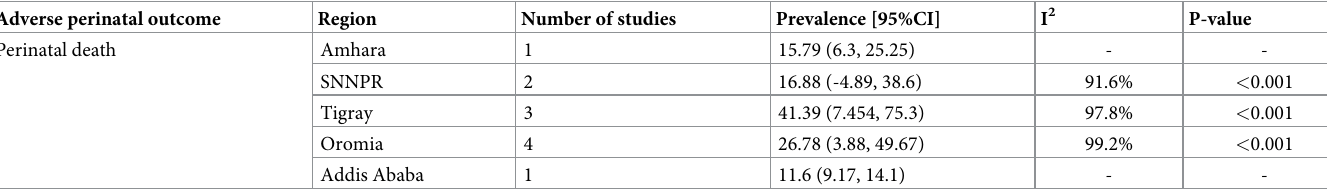
Table 2. Subgroup analysis of adverse perinatal outcome due to obstructed labor by region in Ethiopia. Adverse perinatal